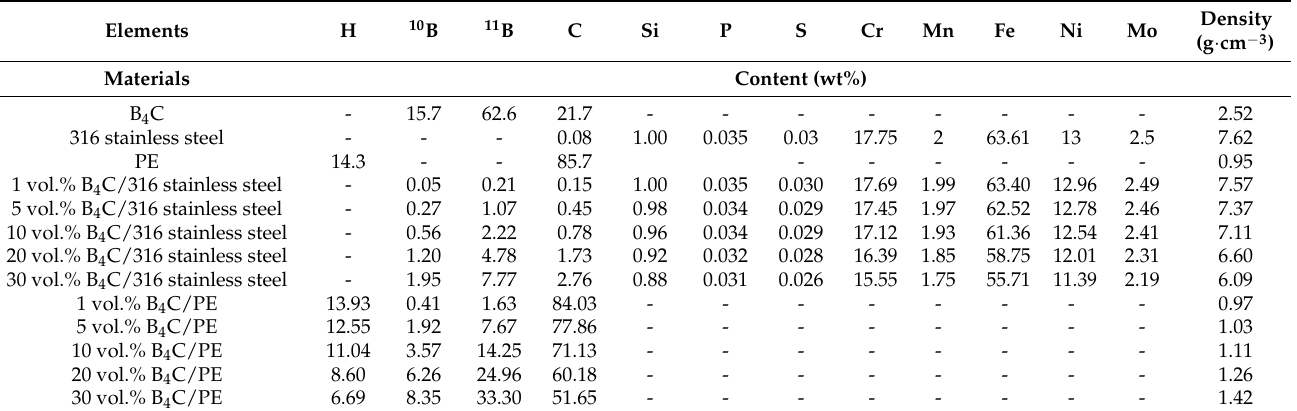
Table 1. The composition and density of